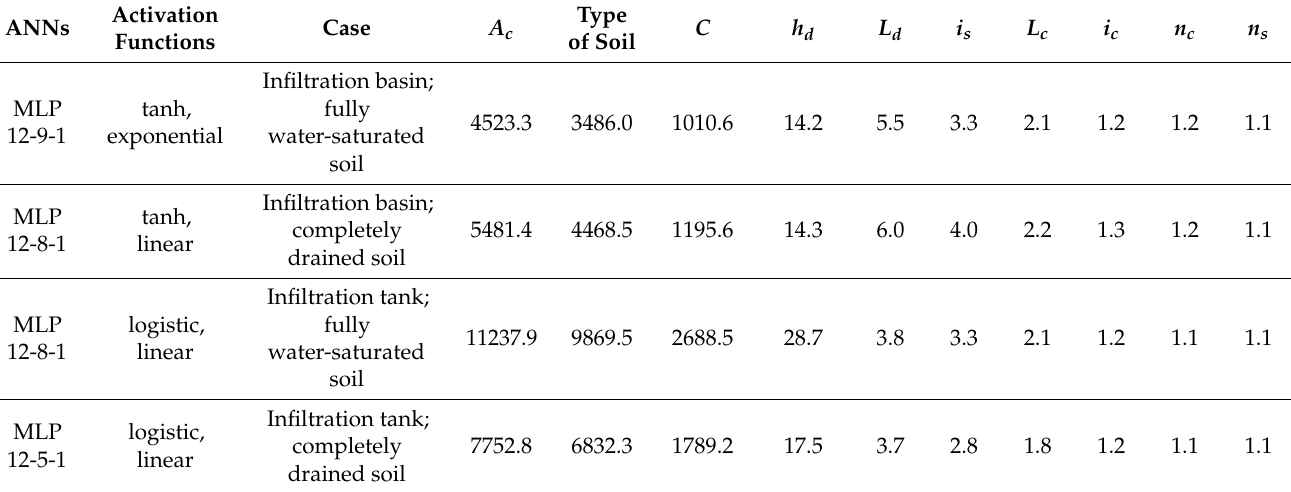
Table 3. Summary of the results of the global sensitivity analysis (ANNs—artificial neural